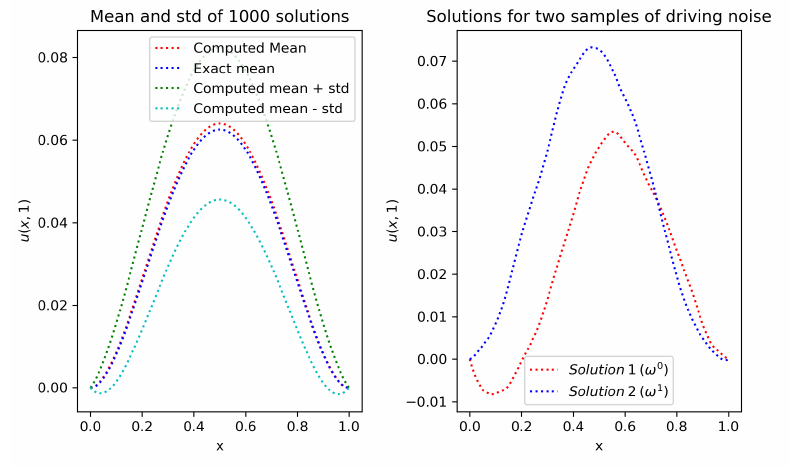
Figure A2. Solution to forward problem: Exact and computed means of solutions at t = 1 and one standard deviation band ( left ), and solutions at t = 1 under two realizations of white noise ( right ).